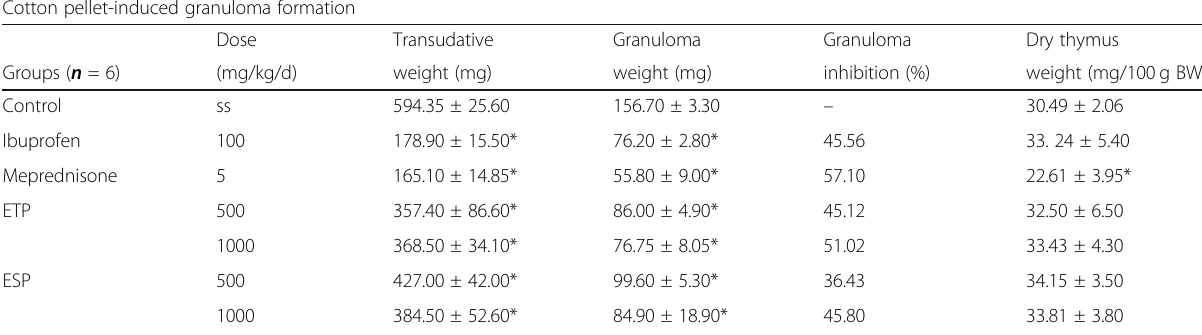
Table 2 Effects of ethanol extracts of propolis of T. fiebrigi (ETP) and S. jujuyensis (ESP) on cotton pellet-induced granuloma formation in rats Cotton pellet-induced granuloma formation